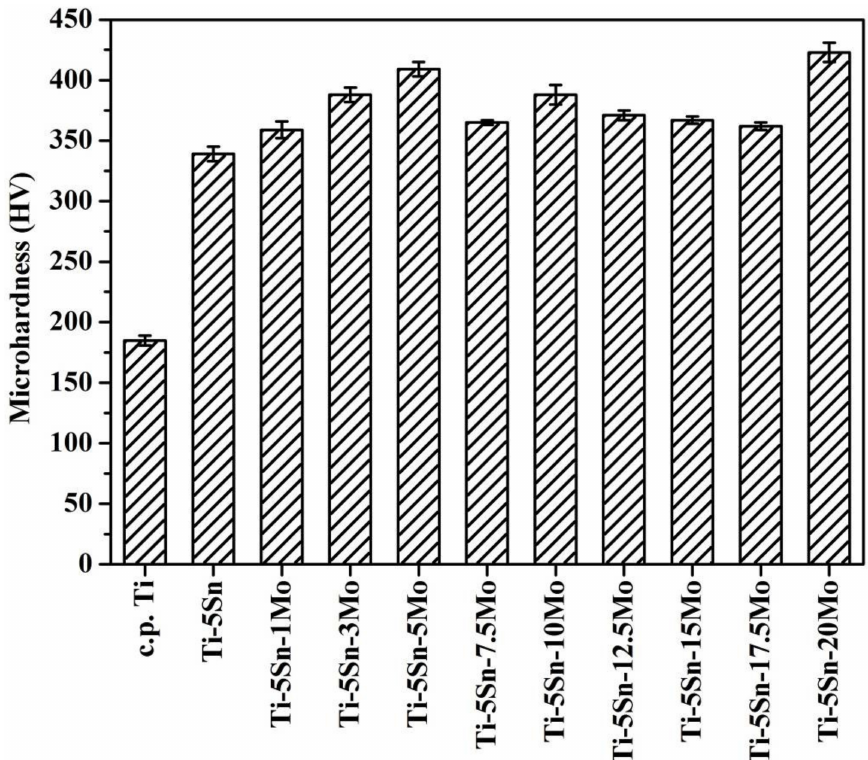
Figure 3. Microhardness of as-cast c.p. Ti, Ti–5Sn, and Ti–5Sn– x Mo